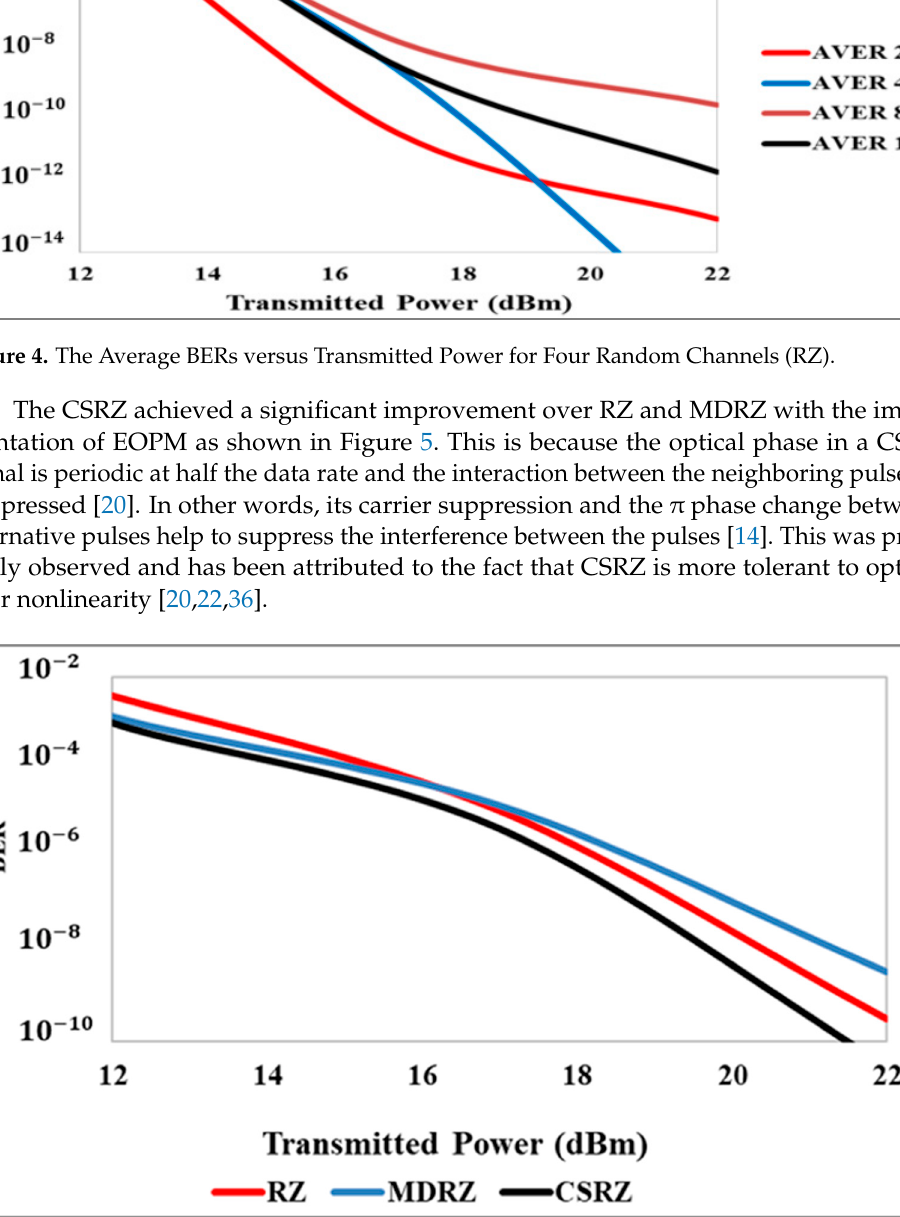
Figure 5. Comparison between Different Modulation Formats’ Performances for the Hybrid Optical CDMA/WDM System.